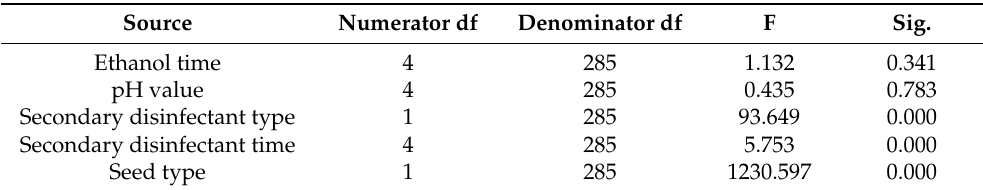
Table 2. A mixed model ANOVA on final germination percentage of dimorphic seeds of Suaeda aralocaspica